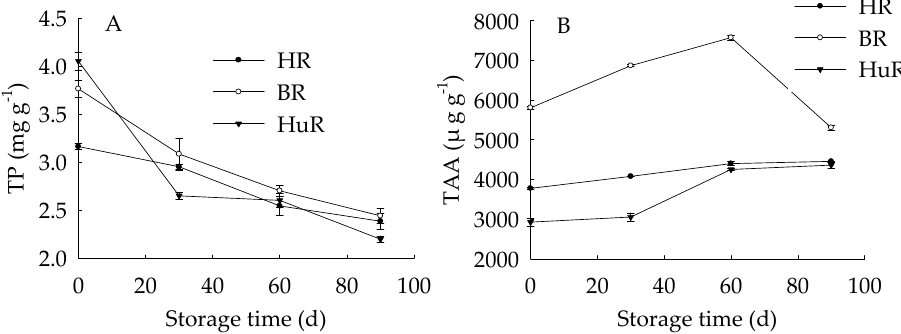
Figure 2. Changes in total phenols (TP) ( A ) and total ascorbic acid (TAA) ( B ) in juice sacs of HR, BR and HuR during postharvest storage. Vertical bars represent SE of the means of three replicate assays. These results indicated that the TP content decreased while the TAA content increased firstly